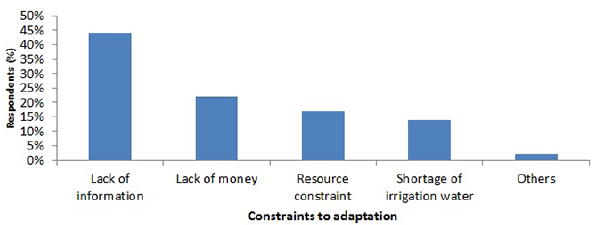
Figure 6. Constraints to adaptation to climate change in the study